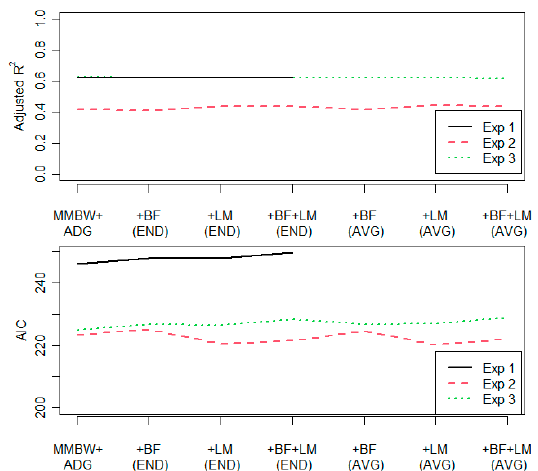
Figure 1. The adjusted R 2 values and the Akaike Information Criterion (AIC) for the fitted models with mid-test metabolic body weight (MMBW, kg) and average daily gain (ADG, kg/d), and models where various combinations of the sub-cutaneous back fat thickness (BF, mm) and the cross-sec- tional area of longissimus dorsi muscle (LM, cm 2 ) are included. END refers to measurement at the end of the experimental period and AVG to an average of measurements at the end and beginning of the experimental period. Table 5. Estimates, standard errors (SE), and p -values for the regression coefficients with a full model including all measured variables. The sub-cutaneous back fat thickness (BF, mm) and cross- sectional area of longissimus dorsi muscle (LM, cm 2 ) measurements are those measured at the end of the experiment since those values were available for all three experiments. For experiments 2 and 3, the model was also fitted using the average BF and LM values. The results were largely the same, except that the p -value of BF in experiment 2 was 0.04. Experiment